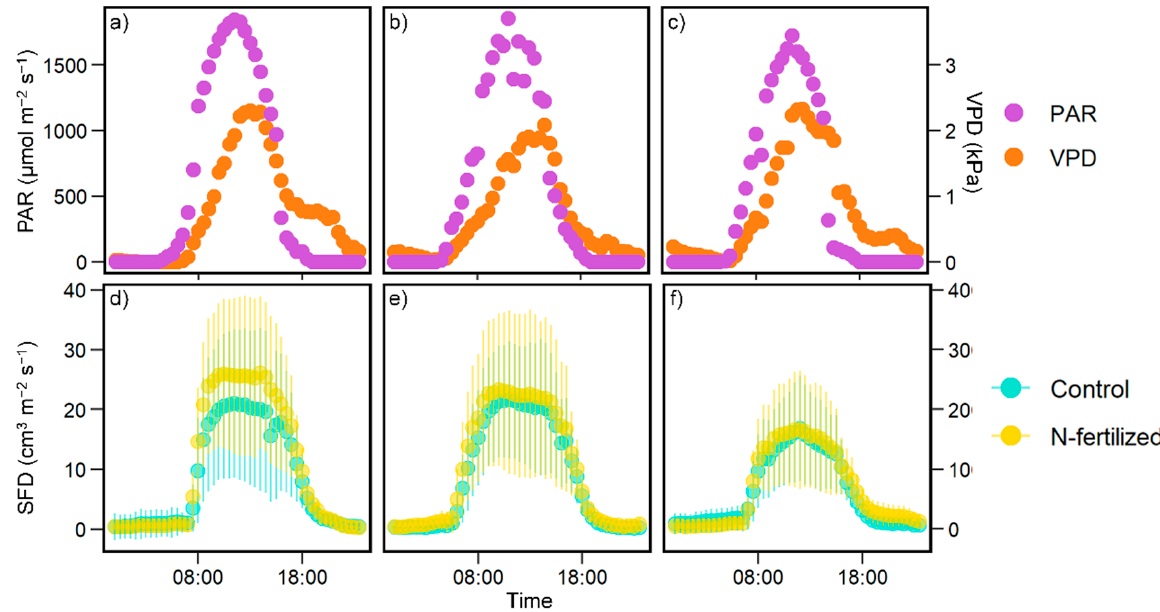
Figure 2. The diurnal variation of ( a – c ) photosynthetic active radiation (PAR; purple circles ), vapor pressure deficit (VPD; orange circles ), and ( d – f ) mean sap flow density (SFD) in the control ( light blue circles ) and the N-fertilized ( yellow circles ) plots. Error bars in ( d – f ) are the standard deviation of SFDs in individual trees ( n = 11–14). The dates used were ( a , d ) 2 August 2019, ( b , e ) 6 August 2019, and ( c , f ) 10 September 2019.